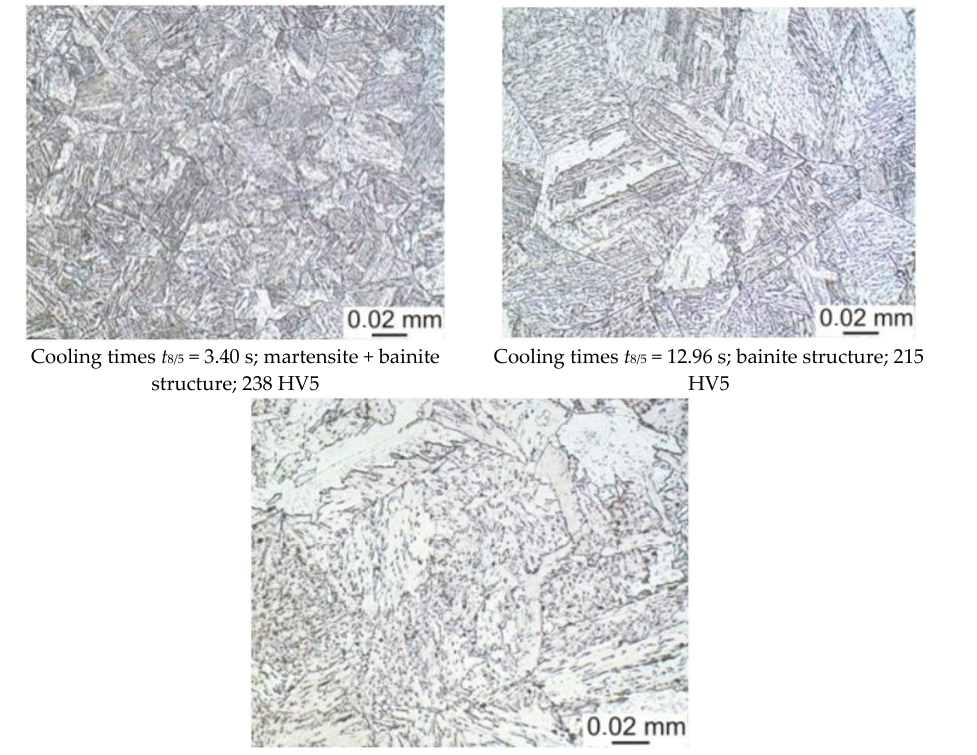
Figure 5. Examples of the microstructure of S700MC steel as a function of the cooling time t 8/5 . The obtained test results revealed that the processes related to allotropic transformation γ – α taking place in steel S700MC during cooling cannot constitute the basis for the assessment of the